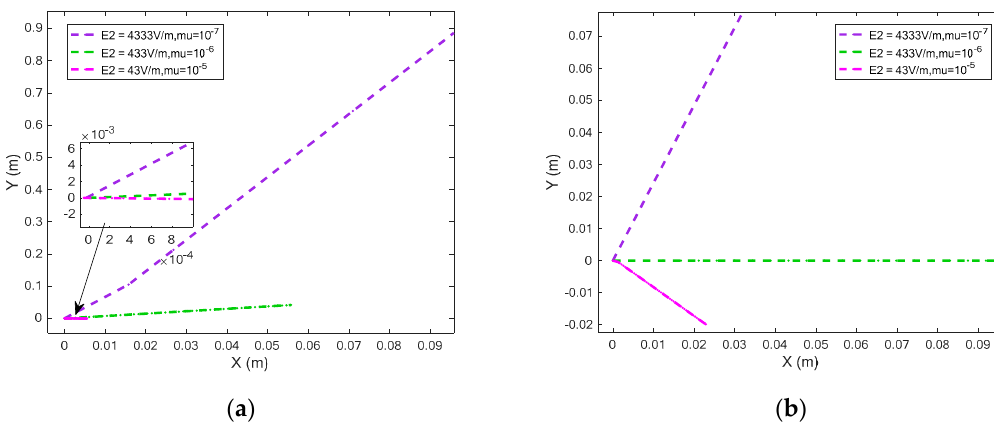
Figure 14. Displacement response of atmospheric particles with different diameters under drag and electric field: ( a ) PM 2.5 ; ( b ) PM 10 .